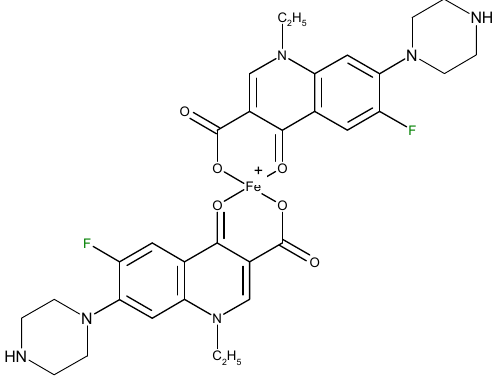
Figure 16. Structure of a 1:2 (metal: ligand) chelate of norfloxacin with Fe 3+